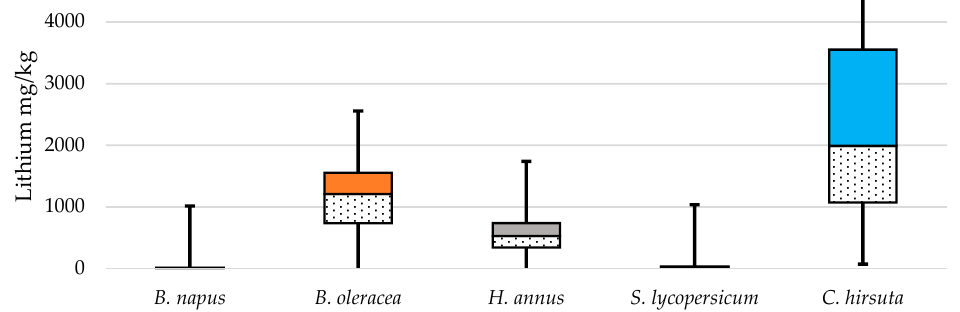
Figure 2. x ̅ Li concentration in leaves of the 5 species ( Brassica napus, Brassica oleracea, Helianthus annuus, Solanum lycopersicum, and Cardamine hirsuta .) (Units = mg/kg).